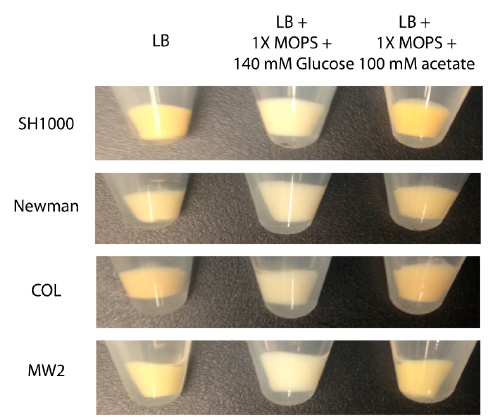
Figure 5. Pigmentation among various S. aureus strains grown in glucose or acetate added medium. Strains SH1000, Newman, COL and MW2 were grown for 12 h in LB broths without or with glucose or acetate. Cell pellets were collected and photographed.